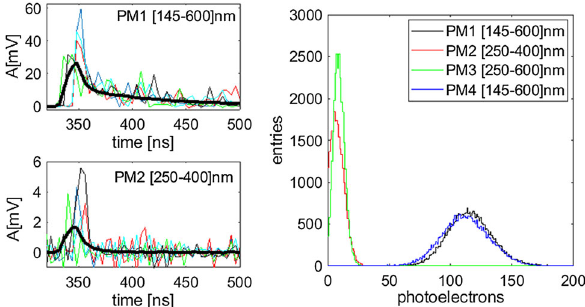
Fig. 4 Left: example of primary scintillation signals acquired during an α -run at 10 bar. Right: signal-integral distributions in the four PM, obtained in the same conditions and calibrated to photoelectrons